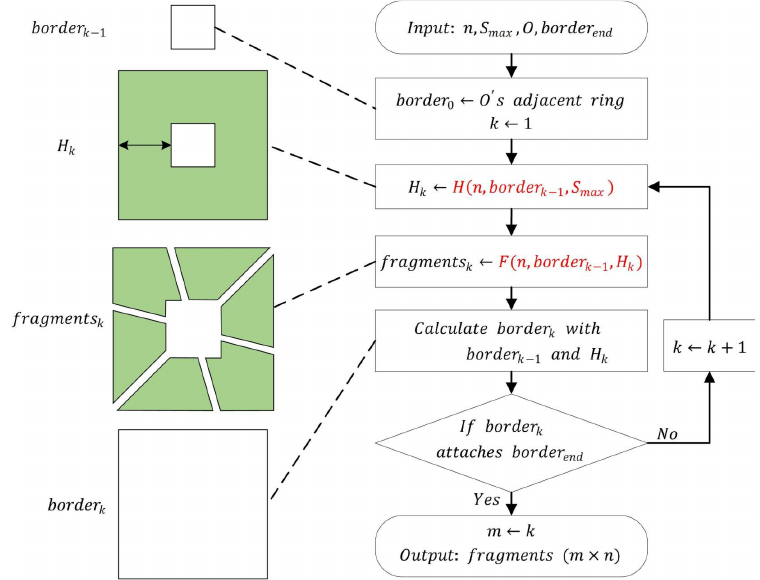
Figure 4. The flowchart of the Multi-level Data Decomposition